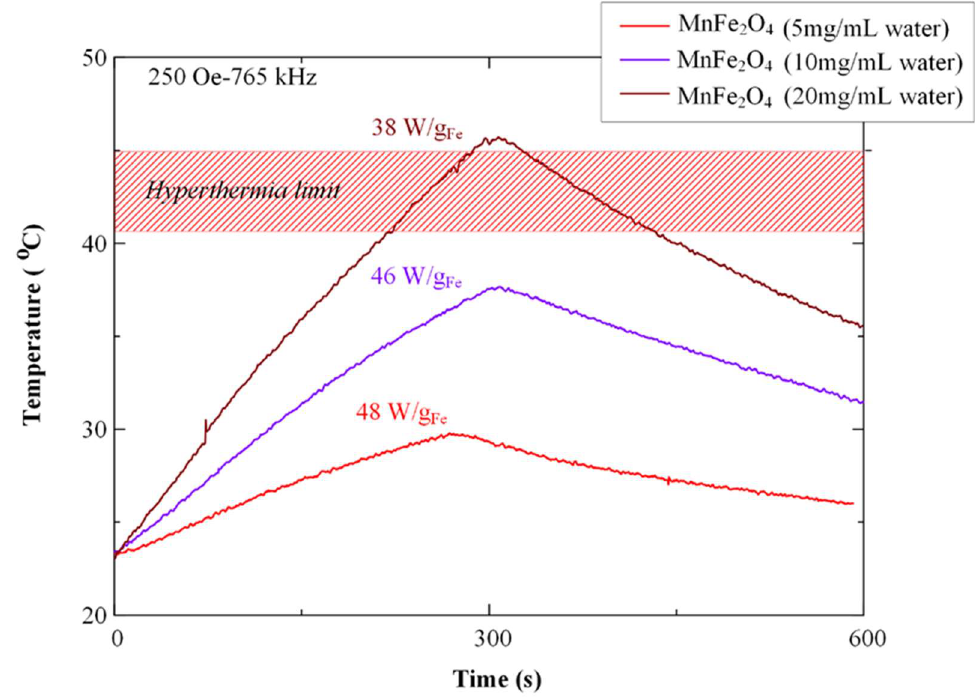
Figure 9. Hyperthermia curves for the prepared magnetic core–shell nanoparticles.